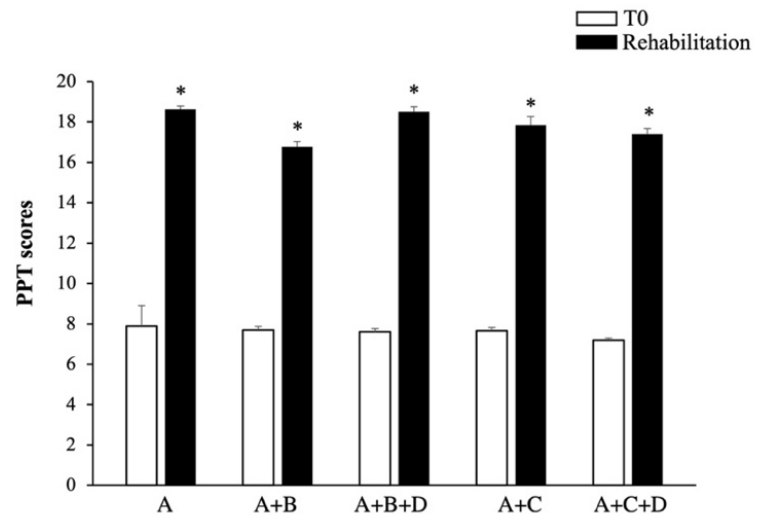
Figure 6. The graph reports the number of pegs placed in 30 s. * p ≤ 0.05 compared with T0. With reference to hand disability, DASH scores were significantly lower (nearly halved) at the end of all rehabilitation paths (Figure 7).